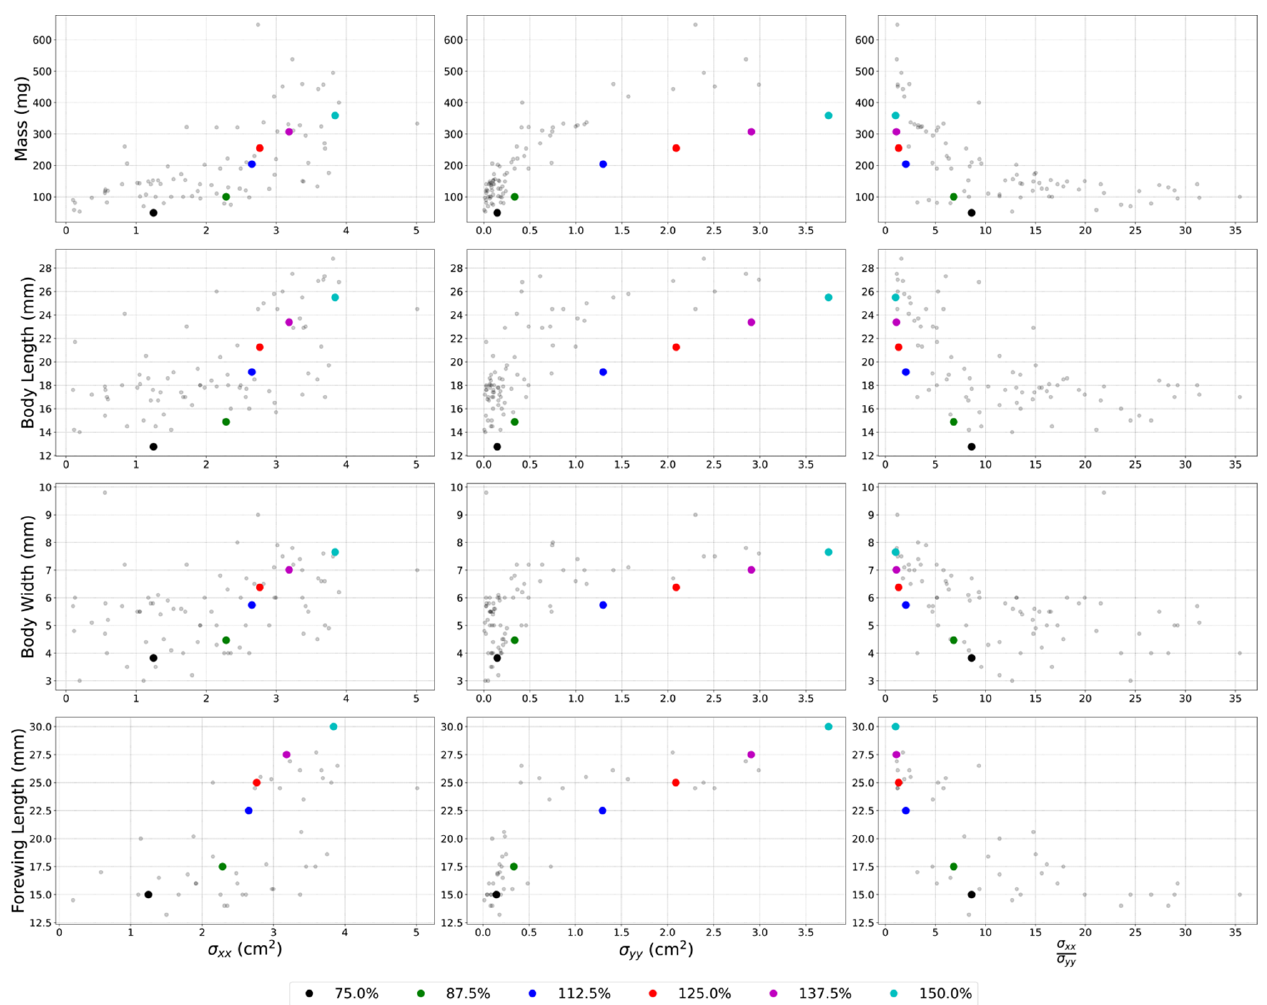
Figure 14. Comparison of a series of simulations in which the Full model (Figure 4a) has been scaled in all dimensions by the percentage indicated in the legend. The grey data points represent the along-body ( σ xx ) and cross-body ( σ yy ) RCS values and their ratio ( σ xx / σ yy ) versus the corresponding morphological attributes reported by Drake et al. [19] for noctuid moths.